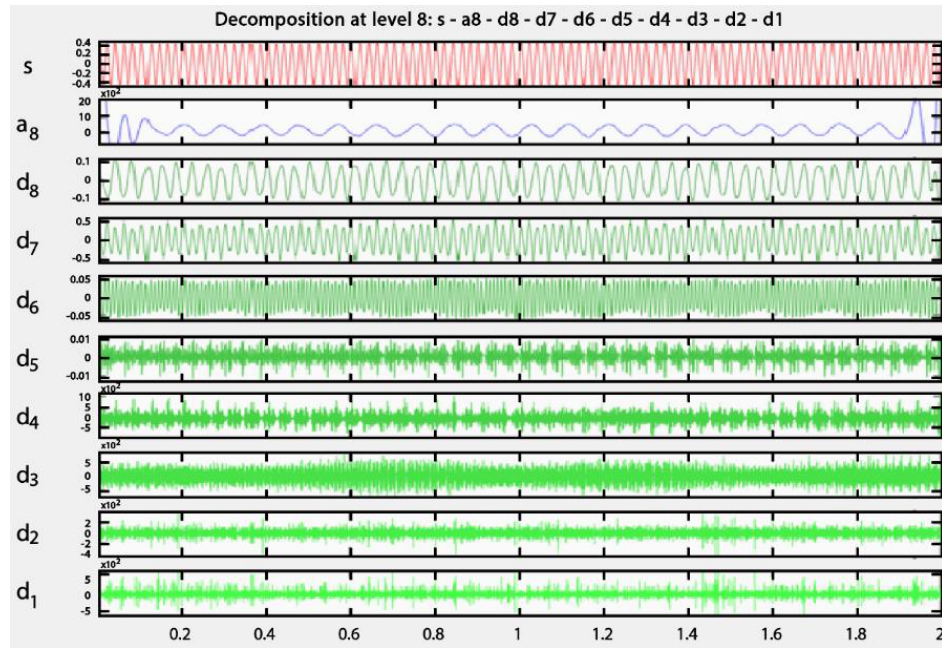
Figure 2. Signal decomposition using DWT, [55,56].